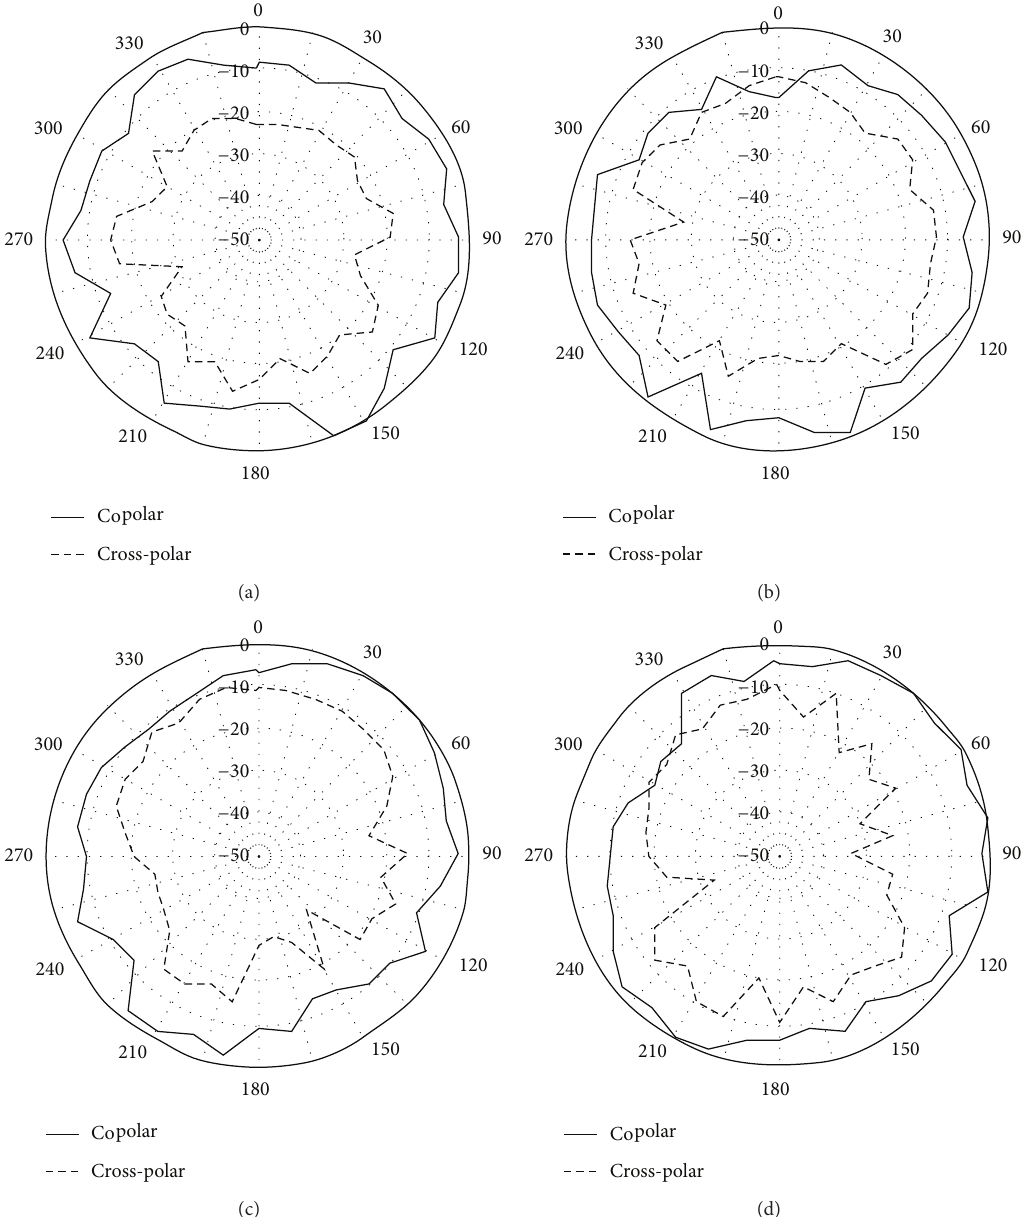
Figure 7: Measured radiation pattern of the antenna. (a) xz -plane at 5 GHz, (b) yz -plane at 5GHz, (c) xz -plane at 9 GHz, and (d) yz -plane at 9